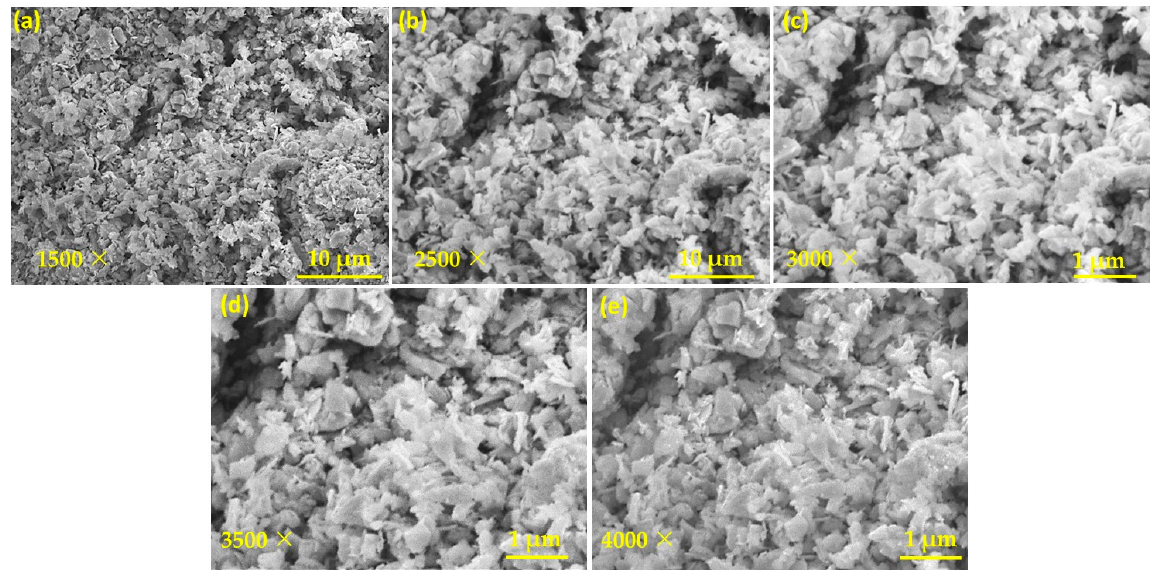
Figure 4. SEM images of CeO 2 /MoS 2 composite at different magnifications ( a ) 1500×, ( b ) 2500×, ( c ) 3000×, ( d ) 3500×, and ( e ) 4000×.